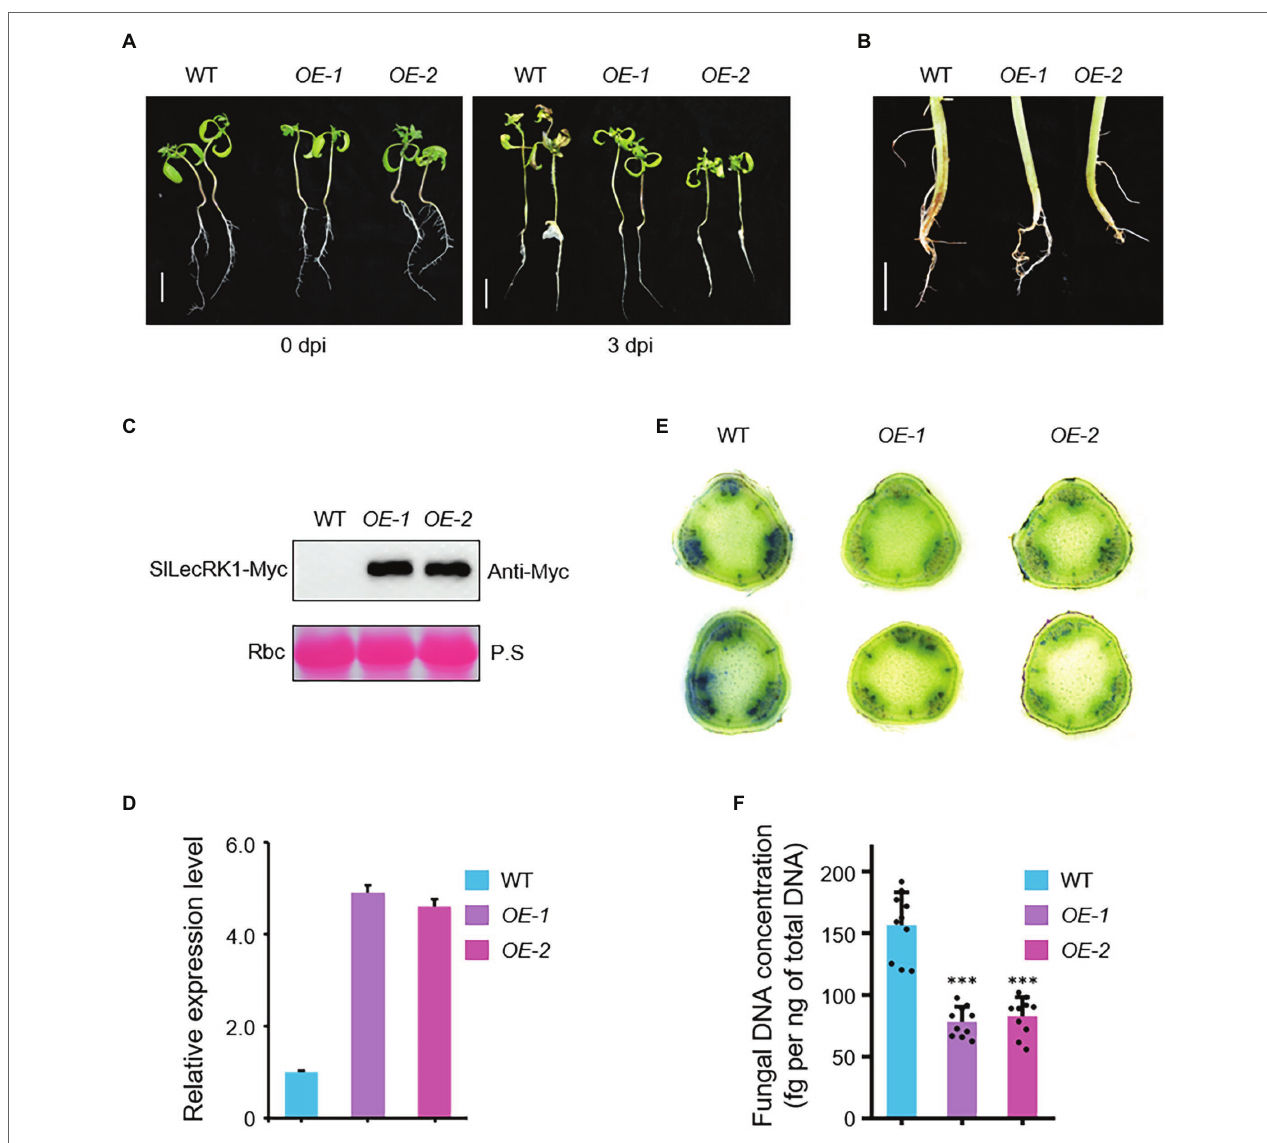
FIGURE 3 | Phenotypes of SlLecRK1 - OE plants in response to FCRR. (A) The post- FORL inoculation phenotypes of 10-day-old SlLecRK1-OE and WT tomato seedlings. Bar, 2 cm. (B) The post- FORL inoculation phenotypes of 30-day-old SlLecRK1-OE and WT tomato roots. Bar, 3 cm. (C) The SlLecRK1 protein levels in overexpression lines probed with anti-cMyc antibodies. Ponceau S (P.S.) staining of RubisCO (RBC) served as a loading reference. (D) The total SlLecRK1 mRNA levels in our overexpression lines. Total RNA was used for qRT-PCR analysis. eEF1 α served as a reference. Data are shown as the mean ± SD from three biological repeats. (E) Cotton blue staining indicating FORL abundance. Stems from WT and OE plants after FORL inoculation for 2 weeks were stained with cotton blue. Representative images of WT and OE plants are shown. Bars, 1 mm. (F) Fungal DNA concentration in WT and OE plants after FORL inoculation for 2 weeks. Different letters denote significant differences by Student’s t- test (*** p < 0.001), n =